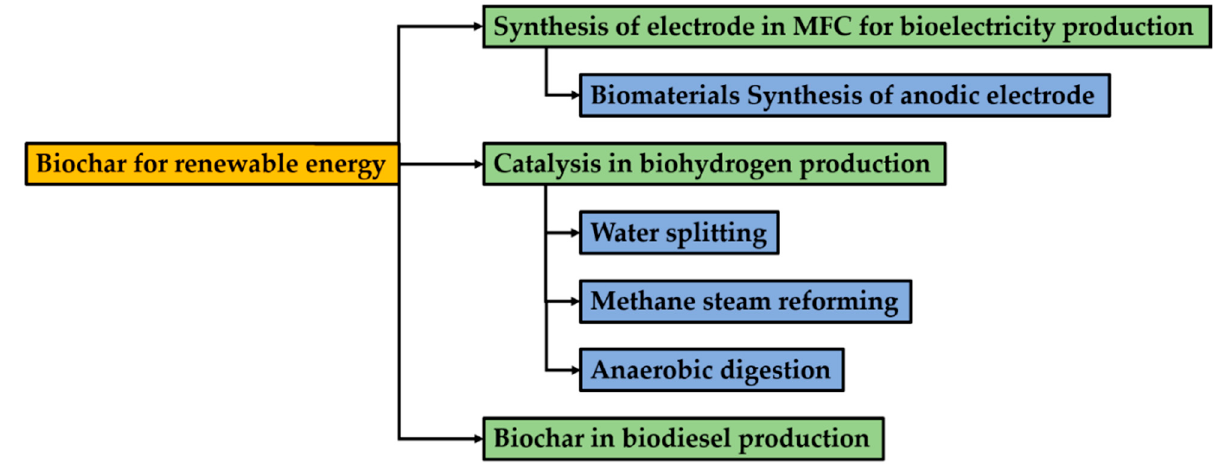
Figure 2. Utilization of biochar for renewable energy production. Table 1. Application of nano-biochar as catalysts for the production of different renewable energy. ( a ) Nano-biochar for MFC for bioelectricity production; ( b ) Nano-biochar for anaerobic digestion for hydrogen production; ( c ) Nano-biochar for biodiesel production. ( a ) As